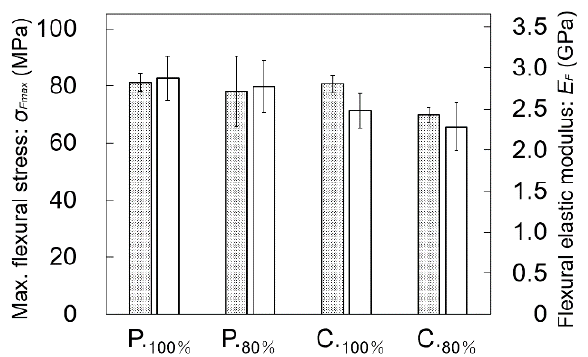
Figure 9. Maximum flexural stresses and flexural elastic moduli of the non-immersed test pieces. Average ± S.D., N = 5.